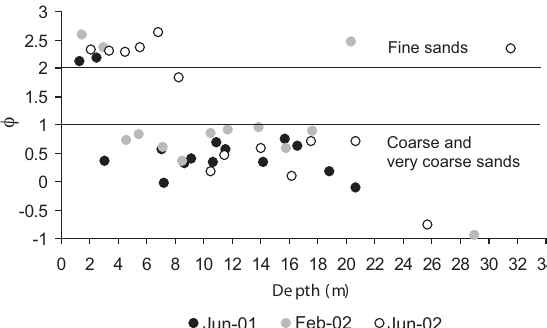
Fig. 2 . – sediment texture (mean grain size, in φ [ φ = log (mm)]) 2 along the depth gradient. Classification, φ [-1 to 0]: very coarse sands; φ [0 to 1]: coarse sands; φ [1 to 2]: median sands; φ [2 to 3]: fine sands.